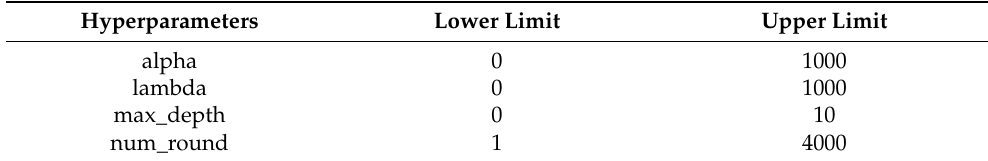
Table 4. Search space of the XGBoost